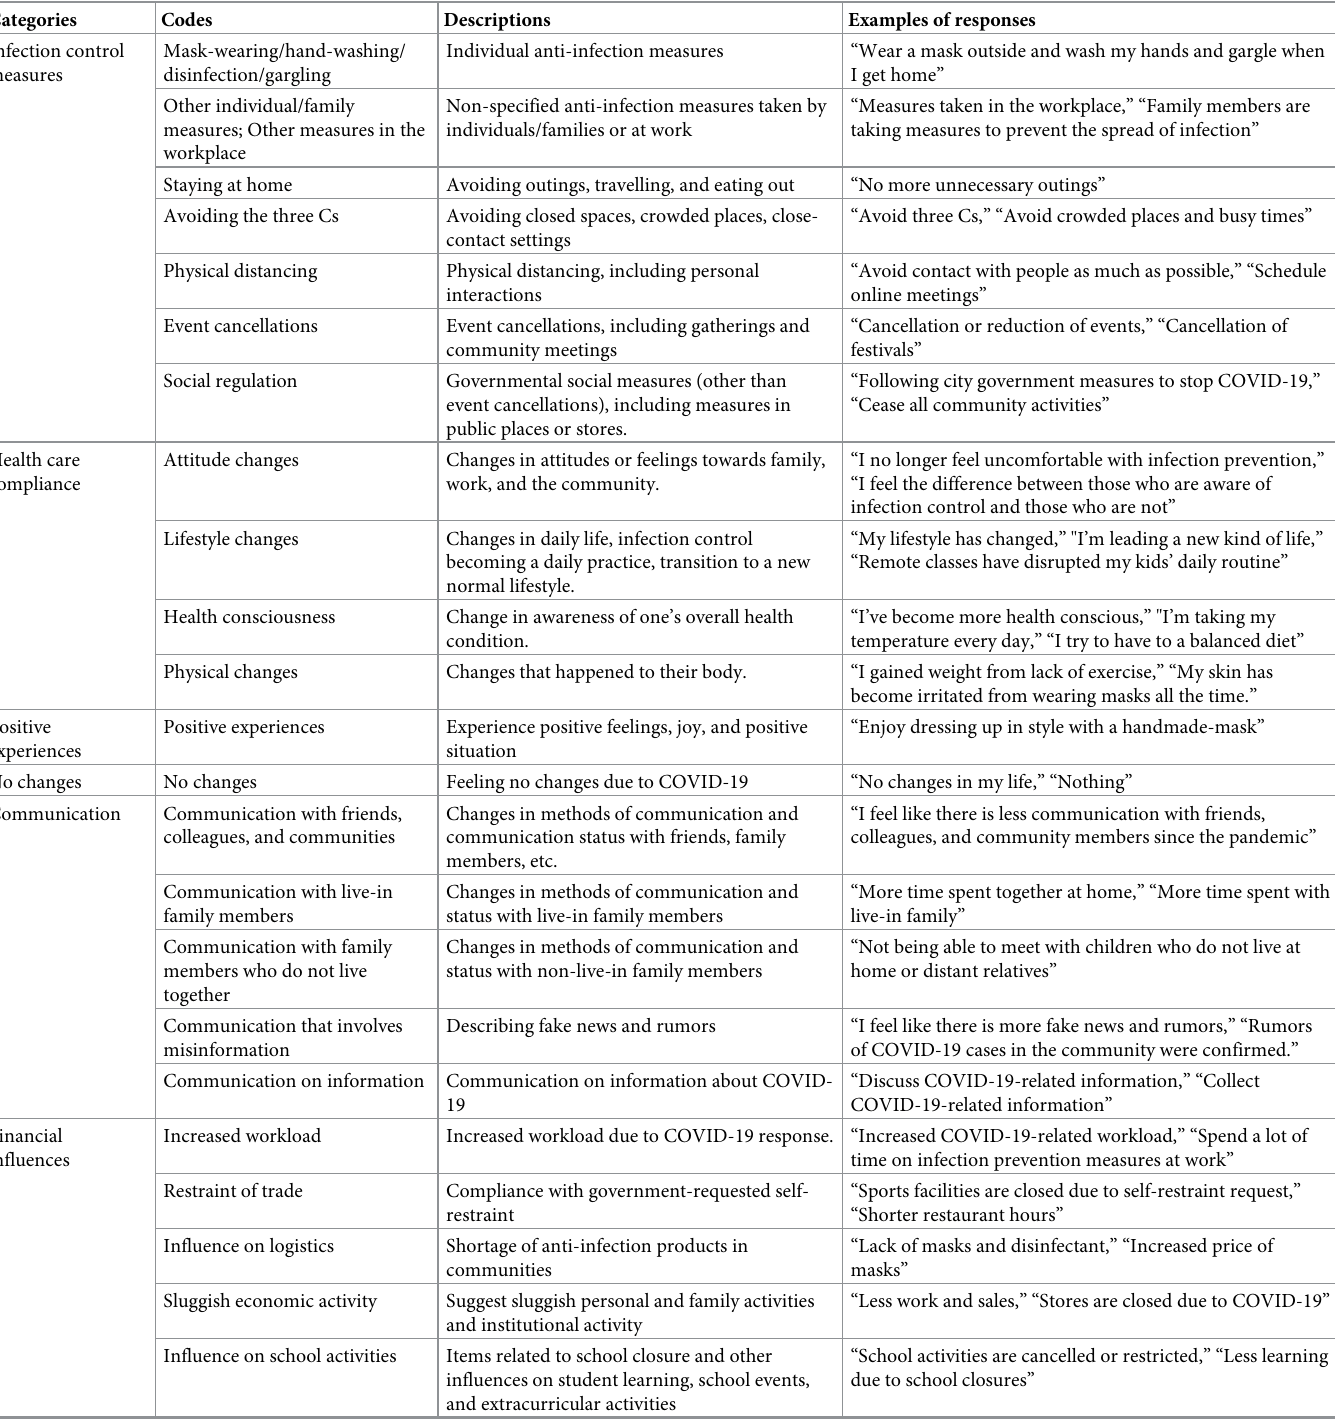
Table 1. Categories, codes, descriptions, and examples of life changes due to the COVID-19 pandemic.